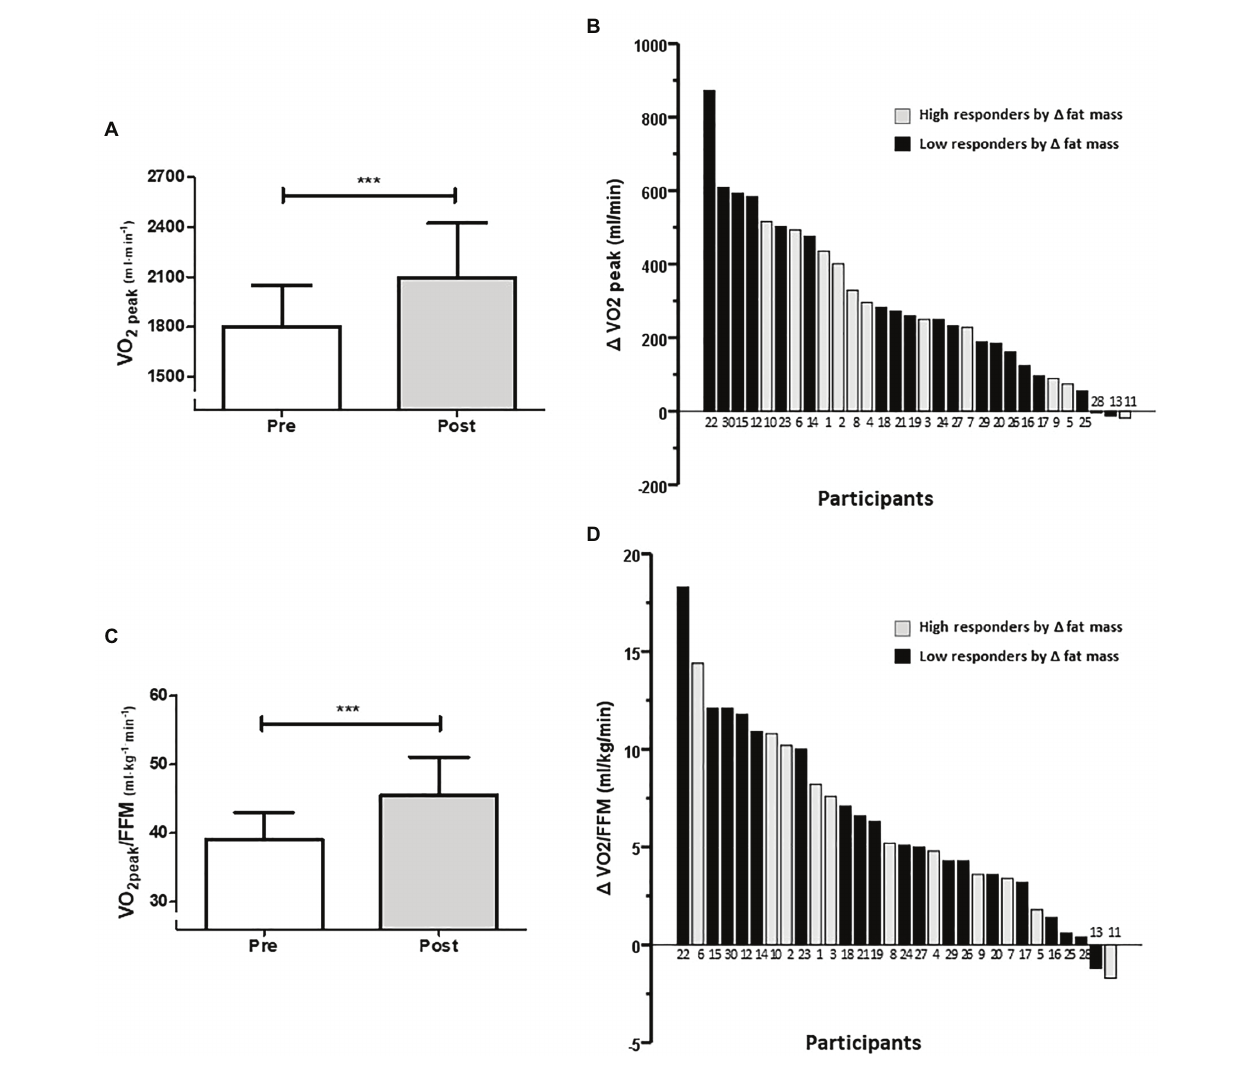
FIGURE 4 | Average changes (A,C) and individual response (B,D) to increase cardiorespiratory fitness (CRF) after 12-week intervention ( A,B : absolute VO 2 peak; C,D : VO 2 peak relative to fat-free mass). Numbers below the bars (B,D) represent the order of magnitude in the individual response to reduce fat mass. High and low responders are identified in relation to the ability to reduce fat mass. *** p <